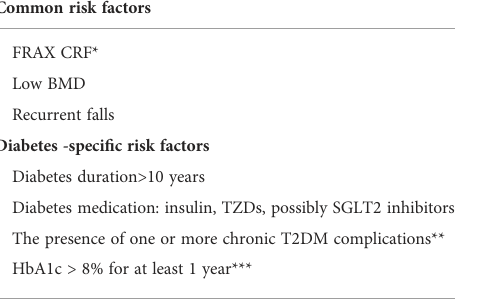
TABLE 1 Risk factors for fractures in